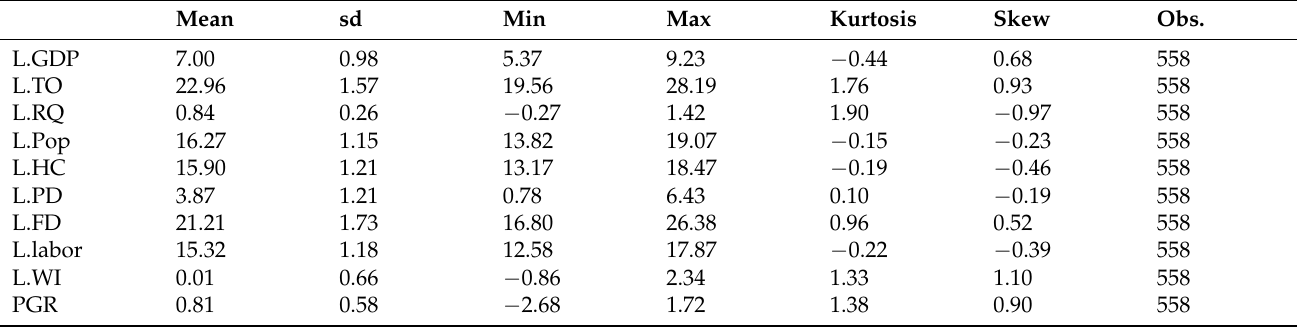
Table 2. Summary